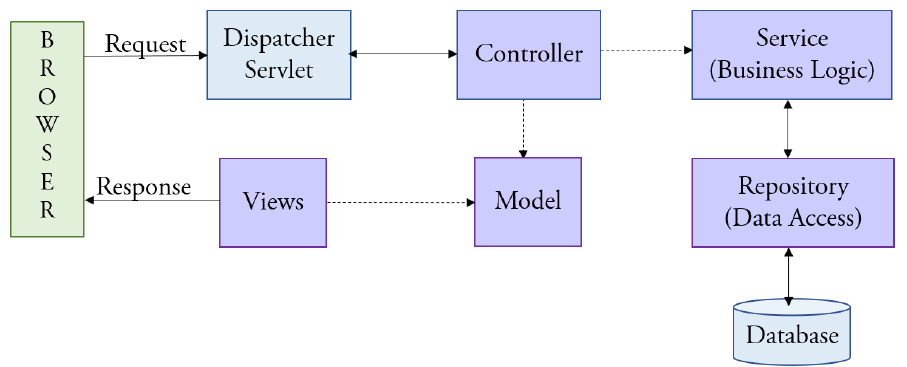
Figure 12. The flow of the parser web application. Violet rectangles denote classes implemented by us, while the blue ones denote components provided by the Spring framework.